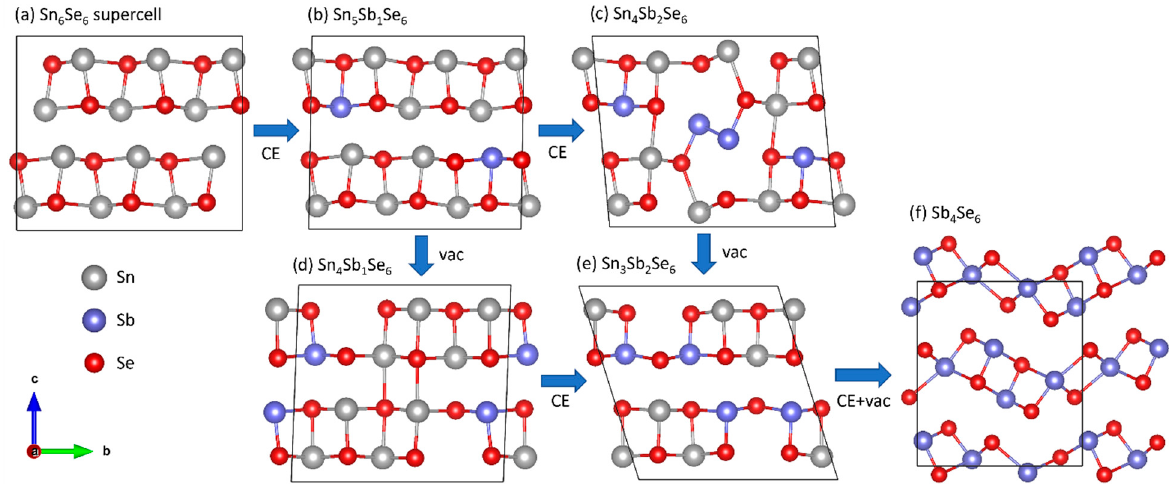
Figure 6. Plausible pathway of structural changes at the atomic level due to cation exchange (CE). Starting from a 1 × 3 × 1 supercell of SnSe ( a ), Sn atoms (grey) are replaced with Sb atoms (blue) while the Se atoms (red) are retained ( b , c ). At some point, Sn vacancies (V Sn ) are created in the cationic sublattice ( d , e ), where Sb atoms preferably occupy positions around the vacancies. As a result of continued cation exchange and vacancy formation and further relaxations, the Sb 2 Se 3 phase ( f ) is